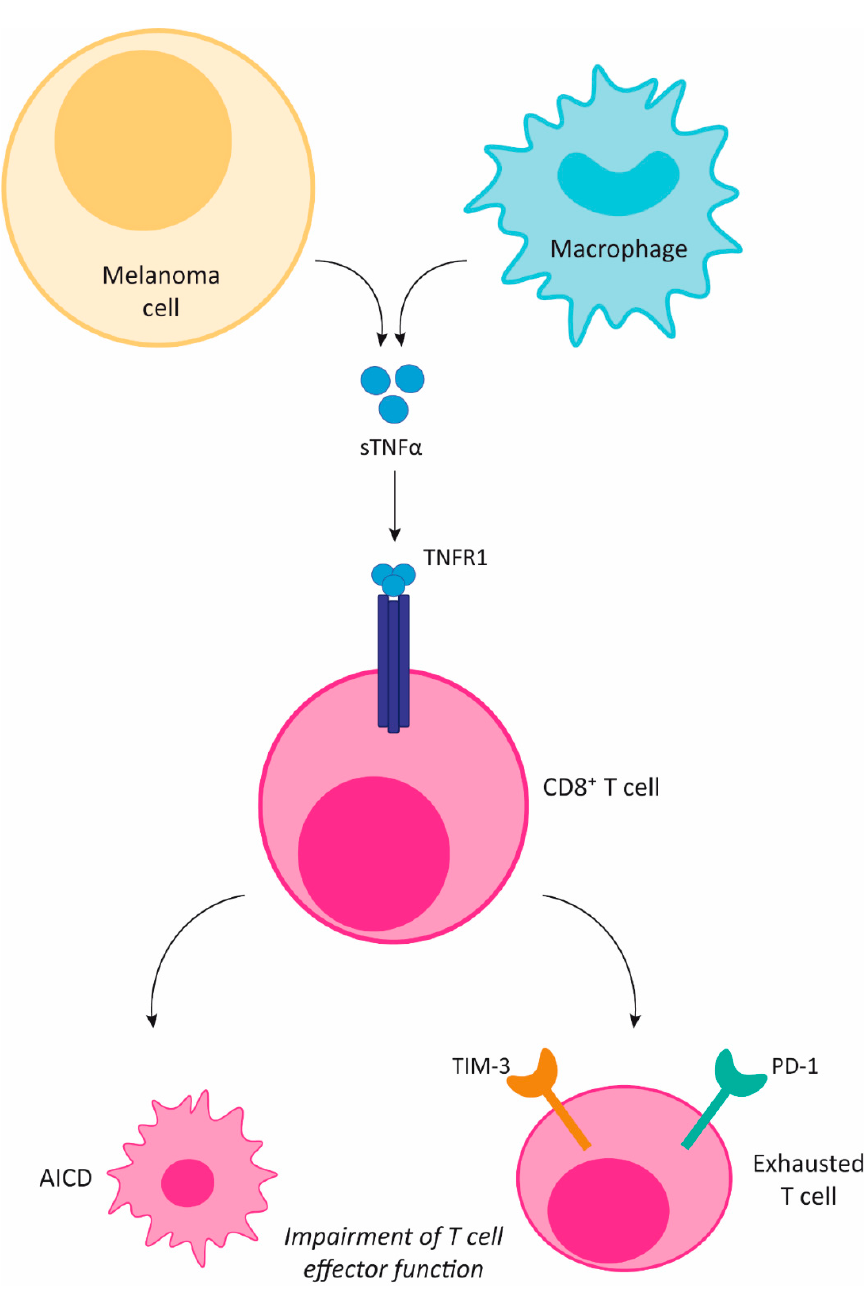
Figure 2. TNF α induces anti-immune checkpoint therapy resistance acting on CD8+ T lympho- cytes. TNF α , produced by either tumor cells or macrophages from the tumor microenvironment, induces activation-induced cell death (AICD) and exhaustion of CD8+ T lymphocytes, impairing the effectiveness of anti-immune checkpoint therapy. TIM3: T-cell immunoglobulin and mucin- domain